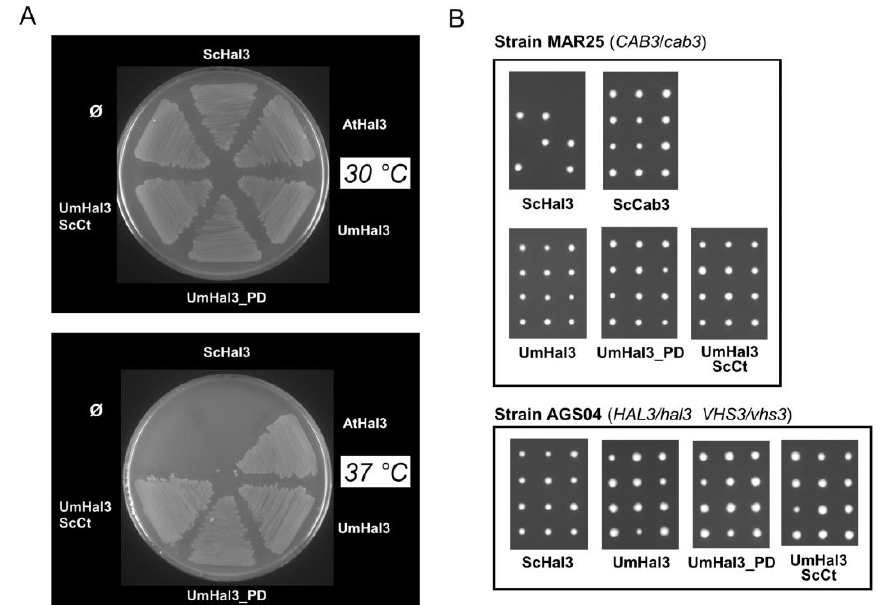
Figure 6. Evaluation of UmHal3 as functional PPCDC. ( A ) The empty pGEX6P-1 plasmid ( ∅ ) and the same vector bearing the Arabidopsis AtHal3 (as positive control), ScHal3 (as negative control), full-length UmHal3, and the indicated UmHal3 variants were introduced into the E. coli strain BW369, which carries the dfp-707ts mutation that abolish PPCDC activity when cells are grown at 37 ◦ C. Transformants were grown at 30 ◦ C, diluted till OD 600 = 0.05, transferred to the permissive (30 ◦ C) or 37 ◦ C (non-permissive) temperatures for 6 h, and then plated at the indicated temperatures. Growth at 37 ◦ C indicate complementation of the ts PPCDC mutation. ( B ) The heterozygous diploid strains MAR25 ( CAB3 / cab3 ∆ ) and AGS04 ( HAL3 / hal3 ∆ VHS3 / vhs3 ∆ ) were transformed with the indicated plasmids, sporulation was induced, and spores from diverse asci (9 to 26 per transformation) were isolated with a micromanipulator and incubated for 3 days to form colonies. Note that U. maydis full-length UmHal3, as well as of its variants containing the PD domain, rescue the lethal phenotype of the cab3 and hal3 vhs3 mutations in haploidy, as denoted by germination and growth of all four spores in the tetrad.